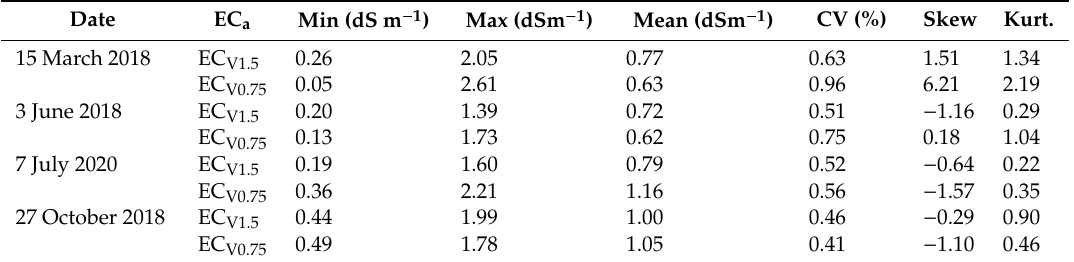
Table 1. The statistical characteristic values of geospatial electromagnetic induction measurements of apparent electrical conductivity (EC a ) at di ff erent